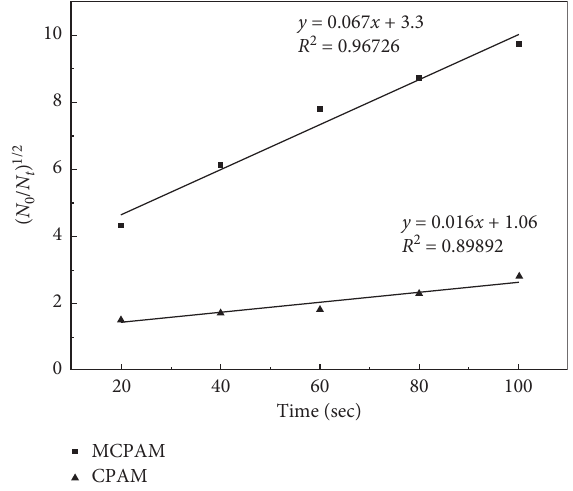
Figure 5: ( N / N t ) 1/2 as a function of separation time in the 0 MCPAM and CPAM